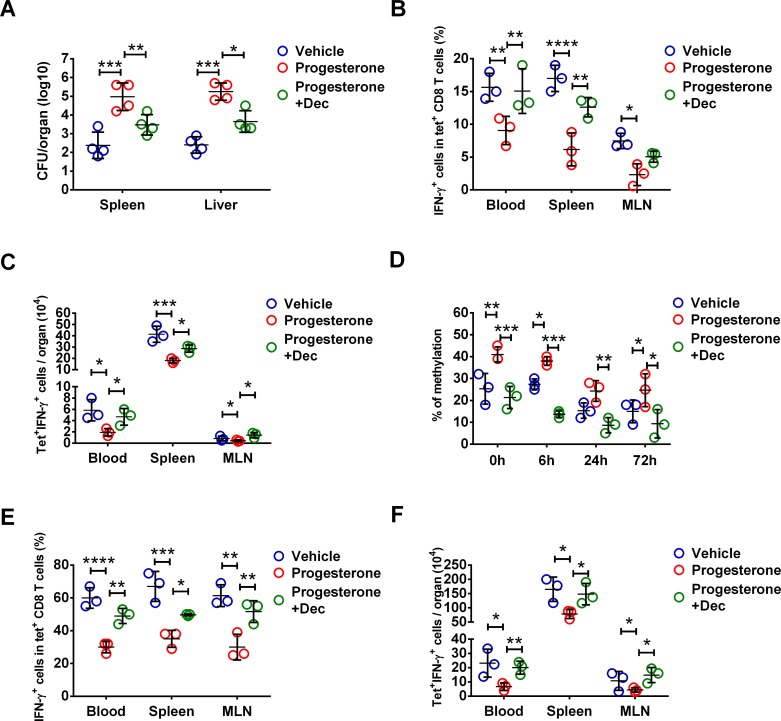
Dependence of DNA hypermethylation in progesterone-induced IFN-γ reduction in antigen-non-specific CD8 Tm cells.Female mice were immunized with rAdHuOVA for 40 days before a 2-week regimen of exogenous progesterone injection, or vehicle as control. Mice were challenged with virulent LM after progesterone administration. In some progesterone injected mice, demethylating agent decitabine (Dec) was administered. Bacterial CFU numbers in the spleen and the liver at 72 hours post infection are shown in (A). At 24 hours post infection, OVA antigen-specific CD8 Tm cells (CD8+H2KbOVA tetramer+) from various organs were stained with intracellular IFN-γ. Statistics of frequency (B) and absolute number (C) of IFN-γ-producing H2KbOVA tetramer+ CD8 Tm cells in various organs are shown. (D) Levels of IFN-γ gene methylation in splenic H2KbOVA tetramer+ CD8 Tm cells are shown at various time points before and within 72 hours after infection. In (E) and (F), cells were stimulated ex vivo with innate cytokines IL-12 and IL-18. Statistics of frequency (E) and absolute number (F) of IFN-γ-producing H2KbOVA tetramer+ CD8 Tm cells in various organs are shown. Error bars represent mean±SD. One-way ANOVA and Tukey’s multiple comparisons test was used to compare between multiple groups. * P<0.05; ** P<0.01; *** P<0.001; **** P<0.0001. Data in (A) are representatives of 2 independent experiments with n = 4 per group. Data in (B) and (C) are representatives of 2 independent experiments with n = 3 per group. Data in (D) are representatives of 2 independent experiments with n = 3 per group. Data in (E) and (F) are representatives of 2 independent experiments with n = 3 per group.